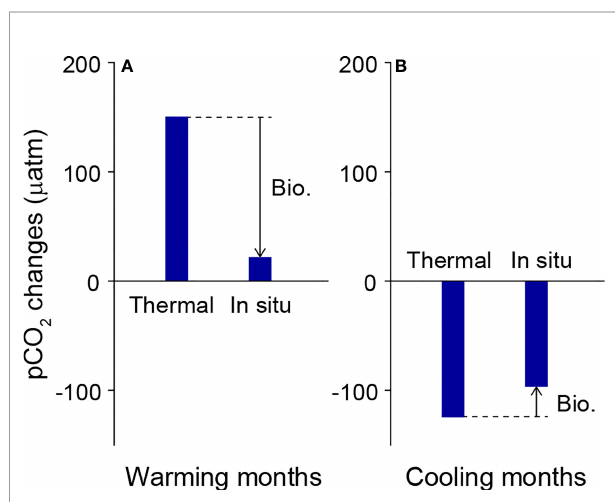
FIGURE 6 | Estimated temperature-driven changes in seawater pCO 2 (4% pCO 2 increase °C -1 ) and those measured at in situ condition during (A) the warming months (mid-July values minus April values; excluding the landing period of typhoons) versus (B) the cooling months (March values minus November values) for the period 2017 – 2021. The differences between temperature-driven changes in pCO 2 and in situ values indicate the changes caused by nonthermal factors, mostly